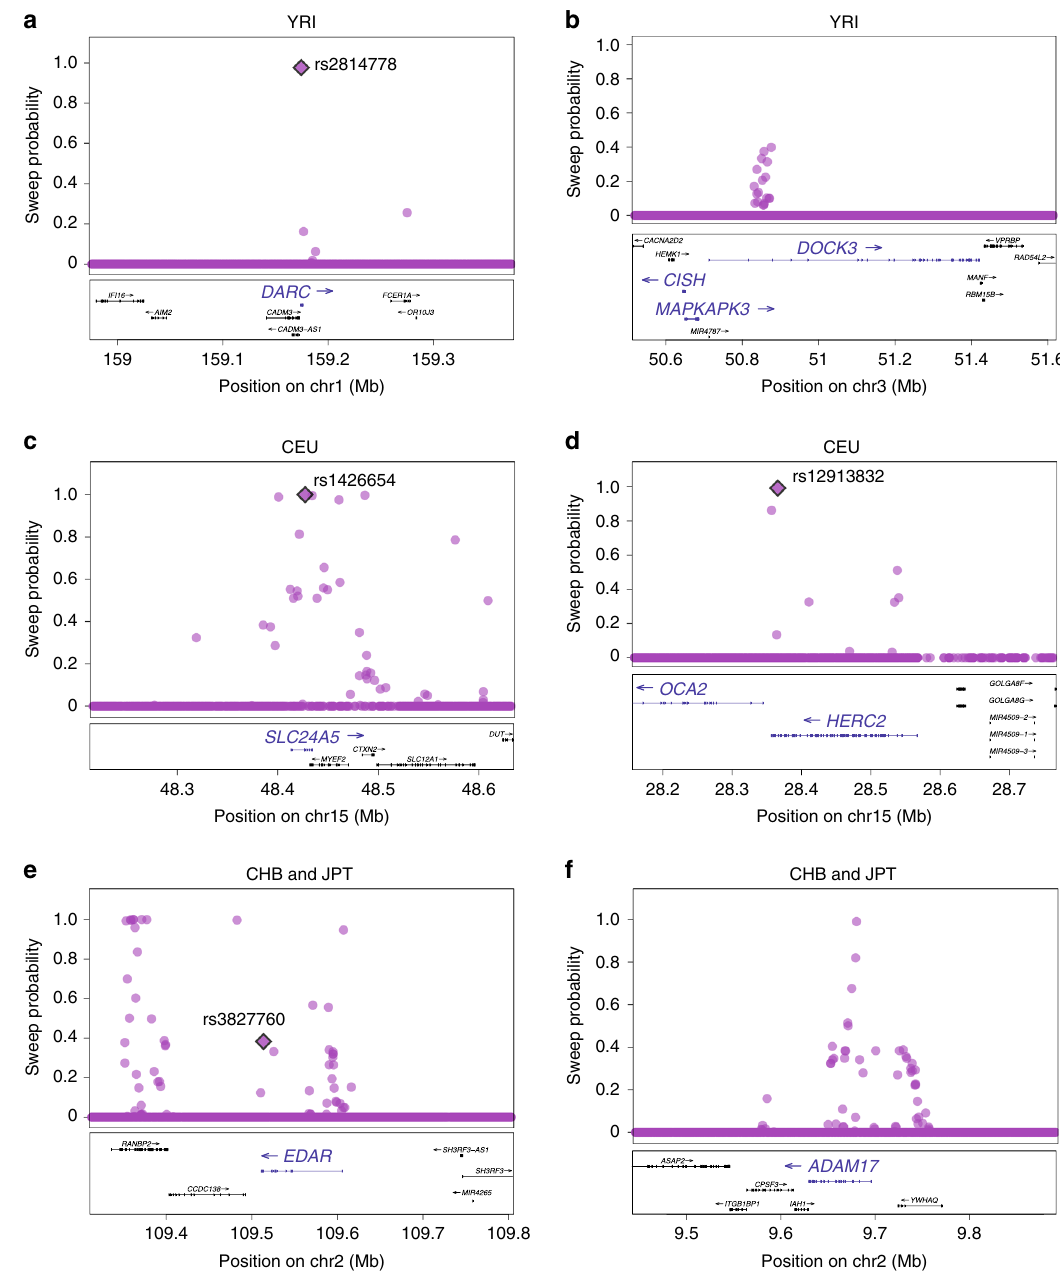
Fig. 2 SWIF(r) localizes canonical adaptive mutations and provides additional evidence for suspected sweeps in YRI, CHB and JPT, and CEU 63 . Plotted points indicate the calibrated posterior sweep probability calculated by SWIF(r) at each site, using prior sweep probability π = 10 − 5 . Plots were made with LocusZoom 64 . Where available, functionally veri fi ed adaptive SNPs are depicted as fi lled diamonds and labeled with rsids. a , b In YRI, two loci where SWIF (r) reports high sweep probabilities are DARC and DOCK3 . DARC encodes the Duffy antigen, located on the surface of red blood cells, and is the receptor for malaria parasites. The derived allele of the causal SNP shown has been determined to be protective against Plasmodium vivax malaria infection 25 . DOCK3 , along with neighboring genes MAPKAPK3 and CISH , are all associated with variation in height, and have previously been shown to harbor signals of selection in Pygmy populations 65 . CISH may also play a role in susceptibility to infectious diseases, including malaria 66 . c , d In CEU, we uncover multiple loci in genes involved in pigmentation, including rs1426654 in SLC24A5 , which is involved in light skin color 24 , and rs12913832 in the promoter region of OCA2 , which is functionally linked with eye color and correlates with skin and hair pigmentation 26 . rs1426654 has the highest sweep probability reported by SWIF(r) in SLC24A5 (0.9992 after smoothed calibration; see Supplementary Data 1); note each panel depicts genomic windows containing multiple genes. e , f In CHB and JPT, SWIF(r) recovers a strong adaptive signal in the vicinity of EDAR ; multiple GWA studies have shown rs3827760 to be associated with hair and tooth morphology 67,68 . SWIF(r) also identi fi es variants with high sweep probability in ADAM17 , which is involved in pigmentation 69 , and has been identi fi ed in other positive selection scans in East Asian individuals